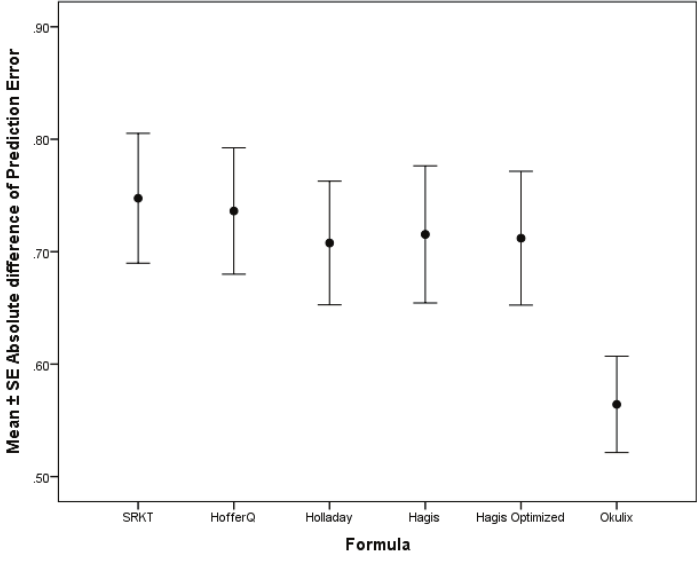
Figure 4. Distribution of absolute prediction errors based on axial length for each formula. The OKULIX and Haigis formulas had the lowest magnitude of change in the absolute prediction error in different ranges of axial length. Most cases of refractive surprise were myopic eyes with ALs > 26 mm.